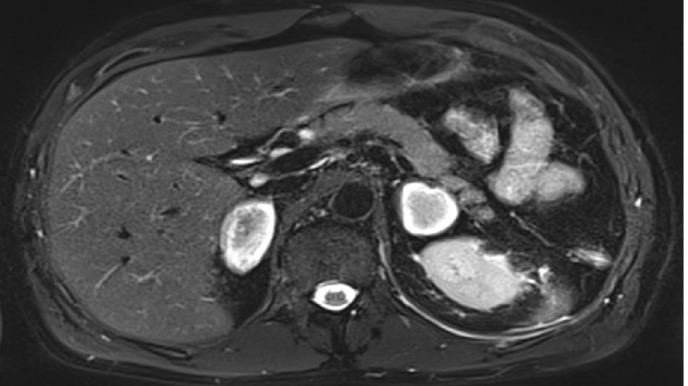
Figure 3. Abdominal magnetic resonance imaging (MRI) at day 21 after admission revealed a bilateral adrenal haemorrhage.